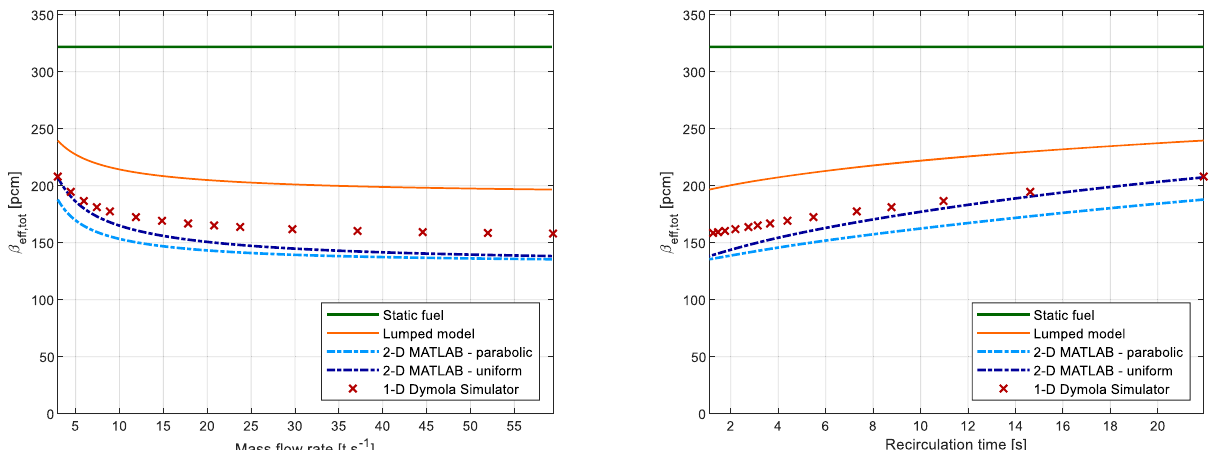
Fig. 12. Total effective delayed neutron fraction versus fuel mass fl ow rate and fuel circuit recirculation time as predicted from the